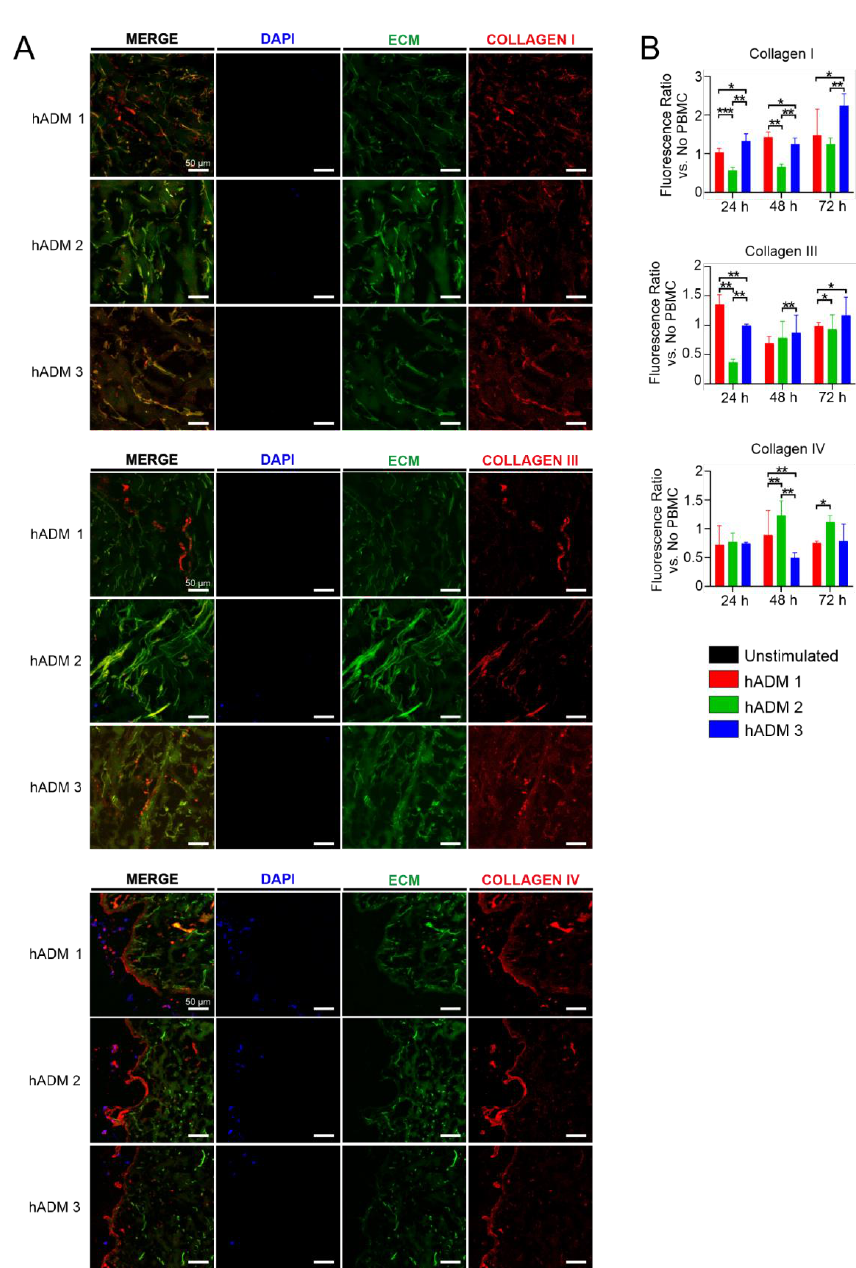
Figure 5. Collagen fibers are retained after coincubation with PBMCs. hADMs were examined confocally after fluorescence-conjugated antibody staining for collagens I, III and IV. Quantifications are derived from focused z-stack photographs using whole channel fluorescence. ( A ) Images for collagens I, III and IV can be seen for each hADM and in 3 separate channels as well as merged together. MERGE: combined representation of channels 1 – 3, detailed below. Channel 1 (DAPI): cell nuclei staining via DAPI using a 405 nm laser. Channel 2 (ECM): autofluorescent collagen fibers and ECM using a 488 nm laser. Channel 3 (specific collagen): specific collagen fibers were stained using a primary and subsequently a secondary fluorescence-conjugated antibody using a 647 nm laser. Process of acquisition and analysis described fully in Materials and Methods section. ( B ) Comparison of collagens in PBMC co-incubated hADMs vs. hADMs without cell culture. Z-stack sections had their absolute fluorescences divided by control sections. Quantification formula can be seen in the Materials and Methods section. Results expressed as medians + interquartile ranges. Two-tailed Wilcoxon matched-pairs signed-rank test used for B. n = 3 with 2 technical replicates; * p < 0.05, ** p < 0.01, *** p < 0.001. All scale bars represent 50 µ